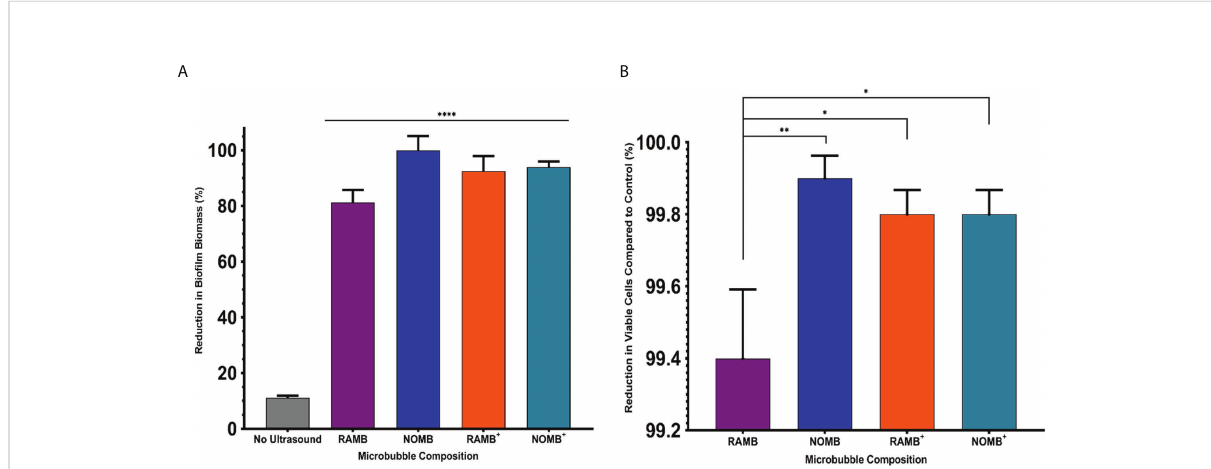
FIGURE 6 (A) The percentage reduction in P. aeruginosa bio fi lm biomass reported here, was determined by calculating the change in surface area of the live/dead stained bio fi lm before and after treatment in a 1 cm 2 area. Each MB composition was diluted 1:5 in PBS containing 4 µg/mL gentamicin, and stimulated using an ultrasound driving frequency of 0.9 MHz, duty cycle of 20% and a 500 Hz PRF. 45 Vpp was applied to the transducer, to reach an acoustic pressure of 0.5 MPa at the target site for 40 s. Signi fi cant differences in the reduction of surface area between all MB formulations and the unstimulated control, are indicated as **** P = < 0.0001, error bars indicate one standard deviation. (B) The viability of the total bio fi lm biomass detached during ultrasound stimulation of MBs, was assessed by quantifying the average reduction in CFU/mL compared to a control bio fi lm. Error bars indicate standard deviation of the mean. The control bio fi lms were exposed to MB and sub-inhibitory gentamicin, but not stimulated with ultrasound. The results represent the combined ef fi cacy of each ultrasound stimulated MB formulation co- administered with 4 µg/mL sub-inhibitory gentamicin. *P < 0.05; **P <